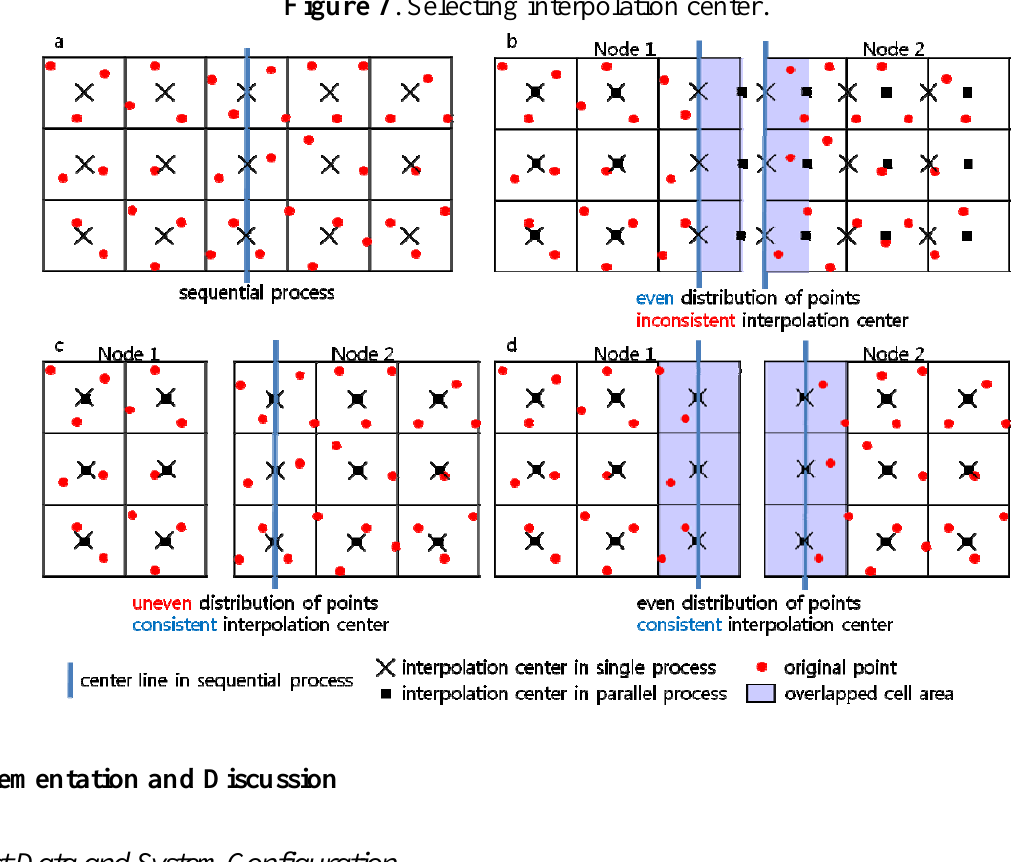
Figure 7 . Selecting interpolation center.